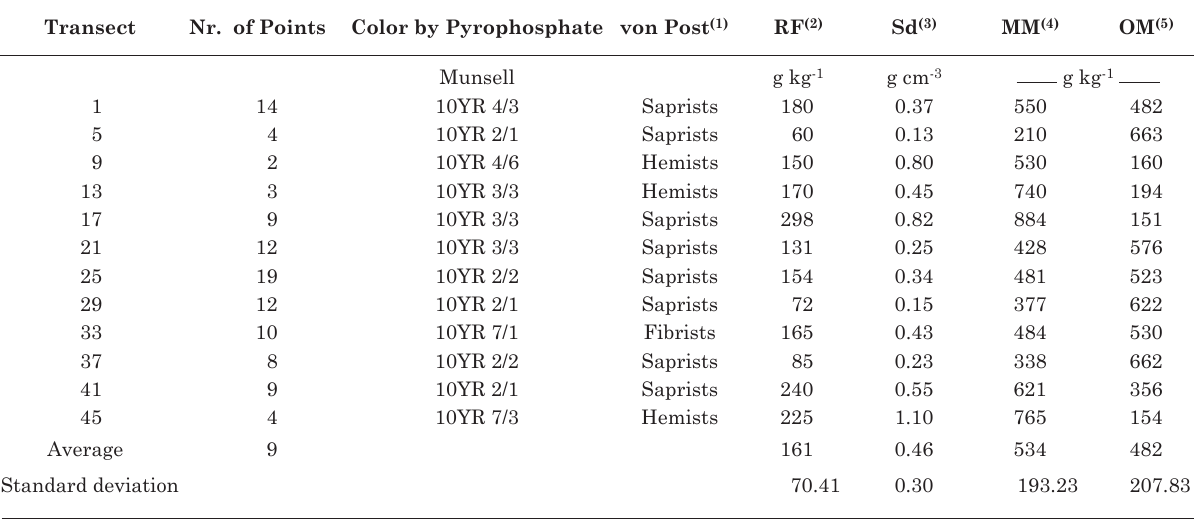
transect nr. of points color by pyrophosphate von post